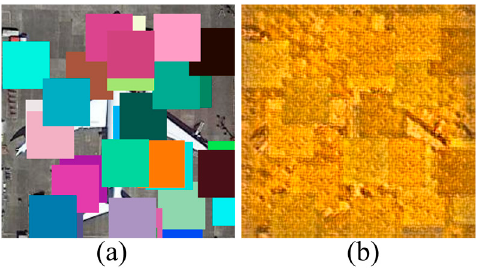
Figure 13. Over noise target. ( a ) Over noise on target. ( b ) Style transfer on target.